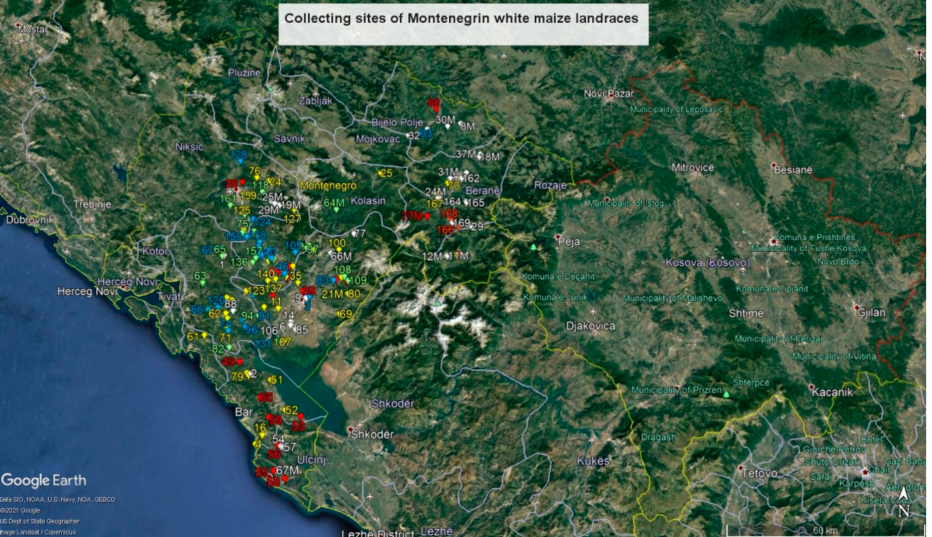
Figure 3. Map of collecting sites for white maize landraces (Maize Research Institute Zemun Polje Gene Bank accessions—designated by number; Montenegrin plant gene bank accessions—designated by number and the letter M; Cluster I—white, Cluster II—blue, Cluster III—yellow, Cluster IV—red, Cluster